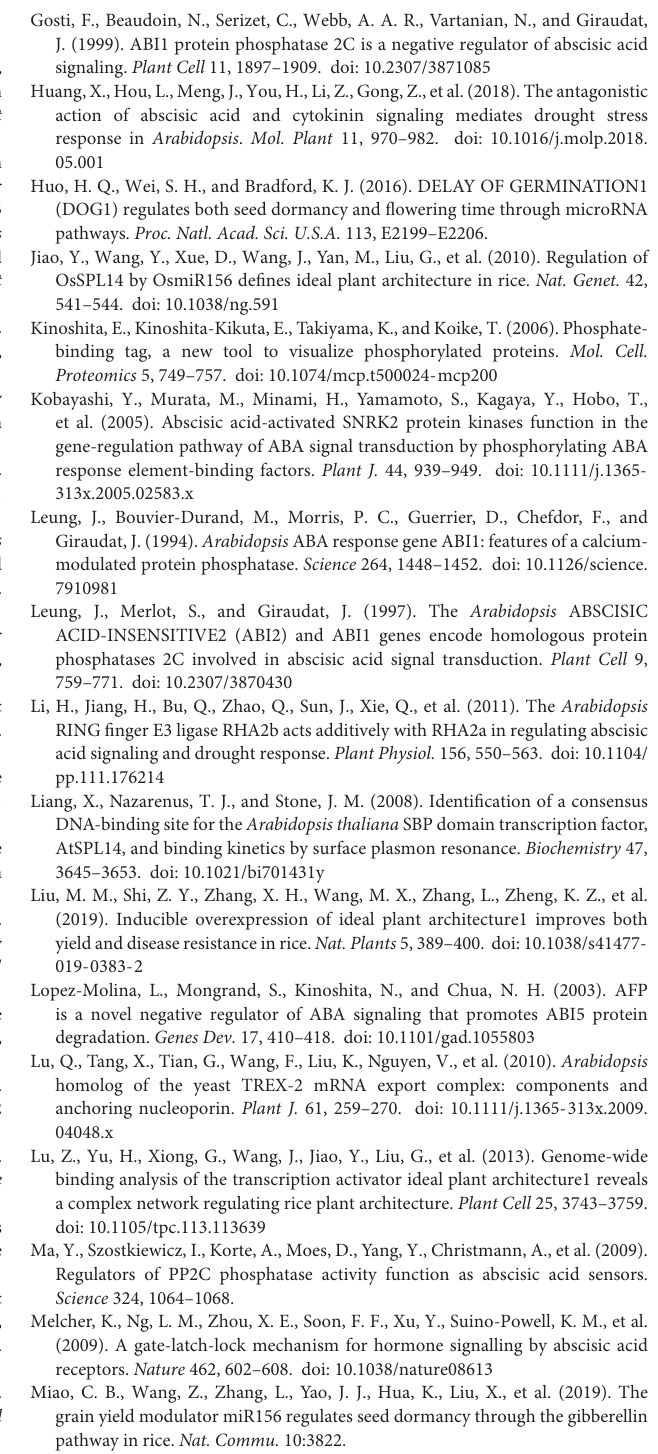
Supplementary Table 3 | Primers used for qRT-PCR. Supplementary Table 4 | Primers used for ChIP-qPCR